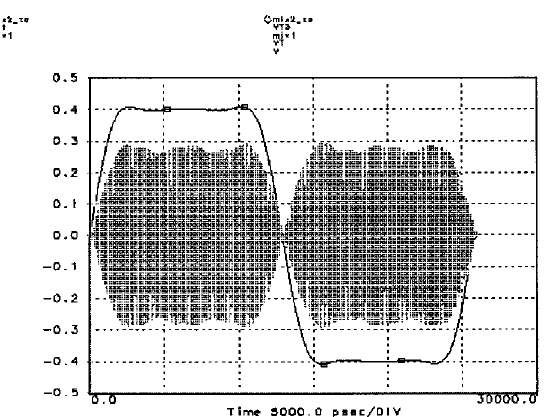
FIGURE 20 Input and output signals during a period of the binary input.